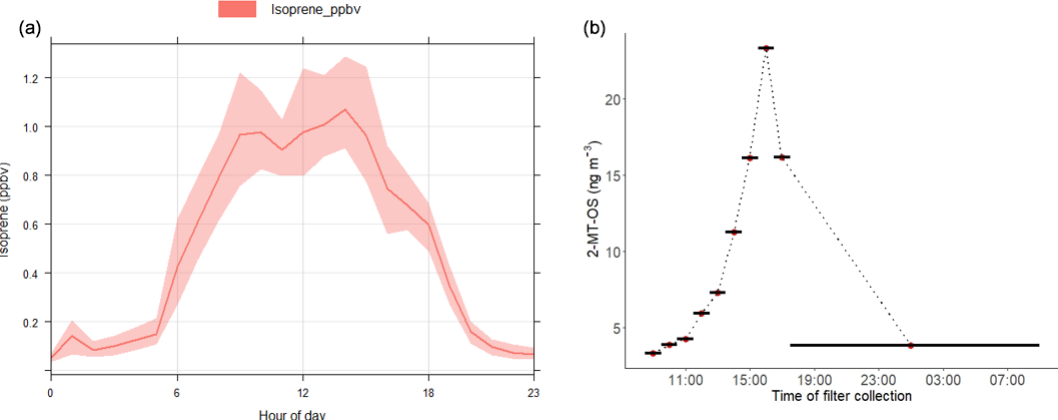
Figure 3. (a) Average diurnal profile of the isoprene mixing ratio measured using DC-GC-FID. (b) Diurnal profile of 2-methyltetrol sulfate (2-MT-OS) in particulate matter (PM 2 . 5 ) collected on filters hourly over the period from 11 to 12 June 2017. Black lines indicate the length of the filter sampling period.